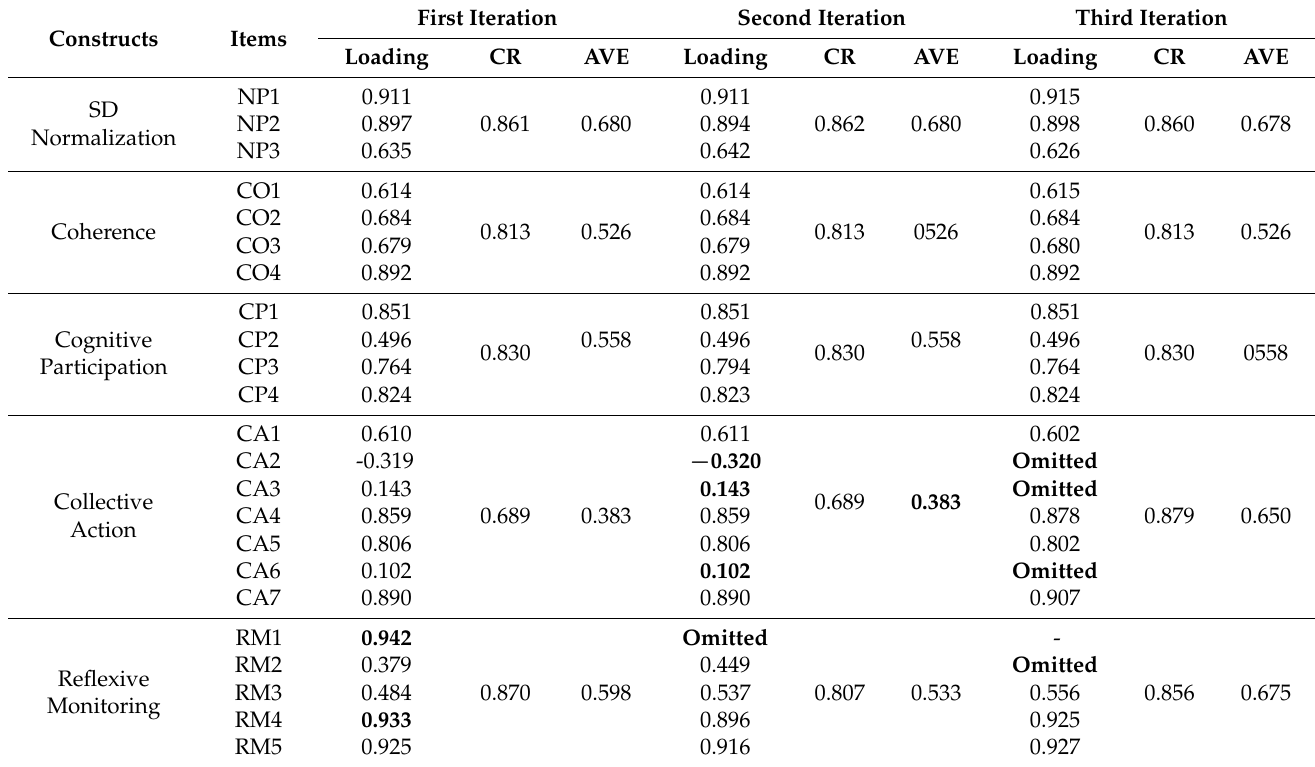
Table 1. Individual item validity and convergent